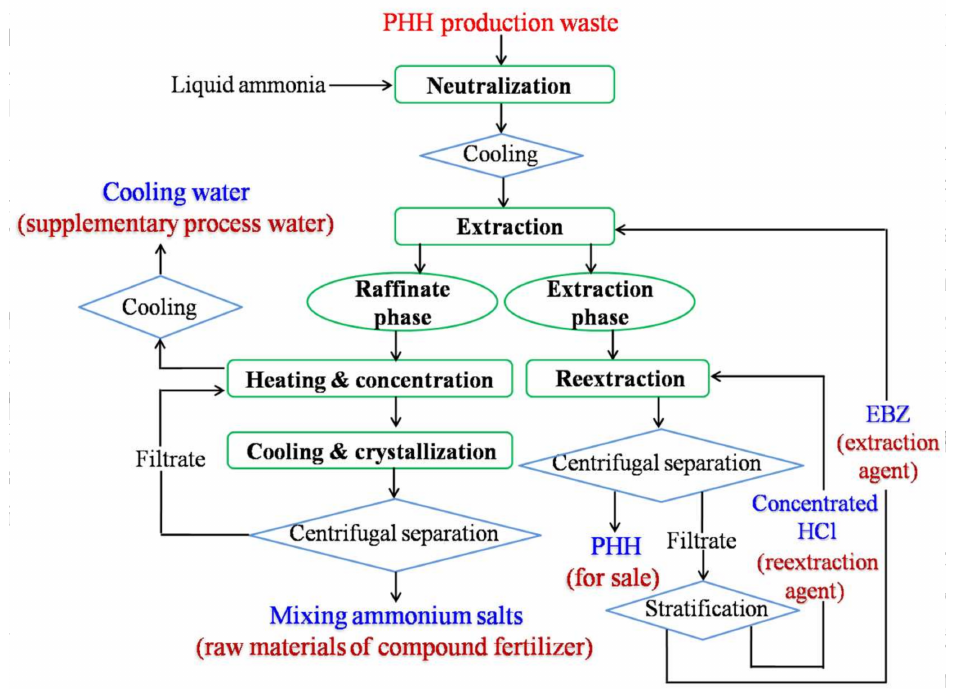
Figure 1. Schematic diagram of treatment process of PHH production